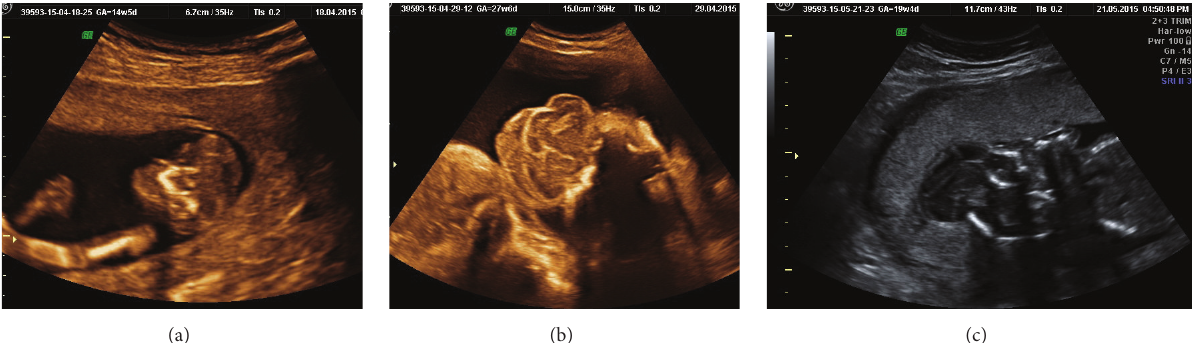
Figure 4: (a, b, and c) show fetal exencephaly that could be diagnosed at 14 weeks but was missed and diagnosed at 19 weeks and as late as 27 weeks.